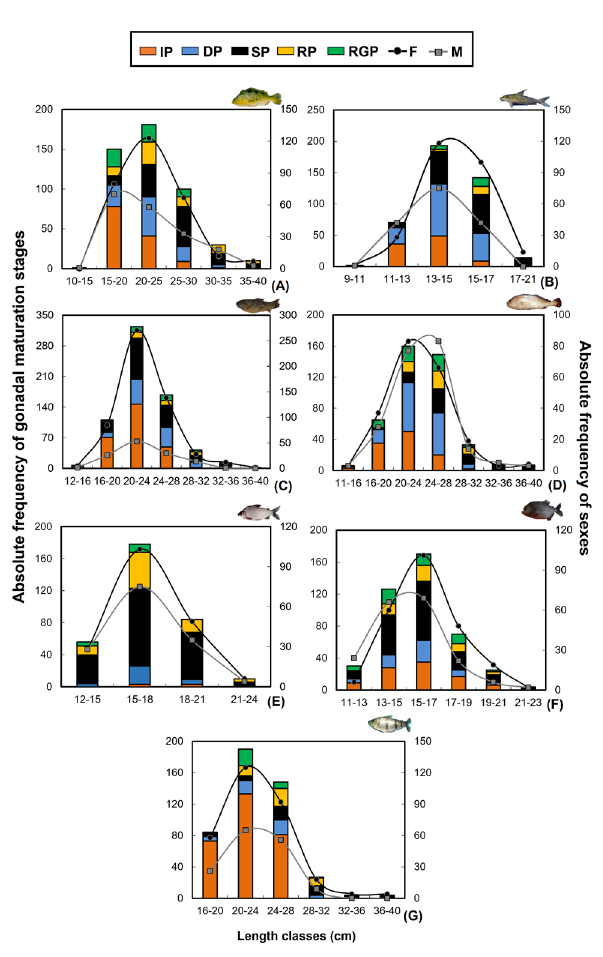
FIGURE 2 | Distribution of the relative frequency by length classes, gonadal maturation stages, and sexes: ( A ) Cichla monoculus ; ( B ) Hassar affinis ; ( C ) Hoplias malabaricus ; ( D ) Plagioscion squamosissimus ; ( E ) Prochilodus lacustris ; ( F ) Pygocentrus nattereri ; and ( G ) Schizodon dissimilis , caught in Baixada Maranhense Protection Area, between January 2012 and December 2016. Immature (IP); Developing phase (DP); Spawning capable (SP); Regression (RP); Regeneration (RGP), F (Female) and M (Males). TABLE 3 | Size at first sexual maturity (L ) for seven species captured in the Baixada Maranhense caught from January 2012 to December 50